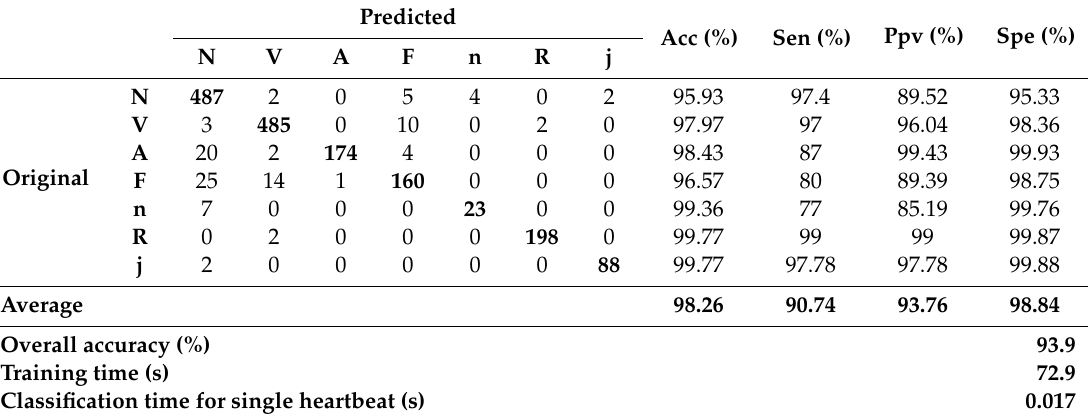
Table 12. Confusion matrix obtained using V1 and V5 leads across 5